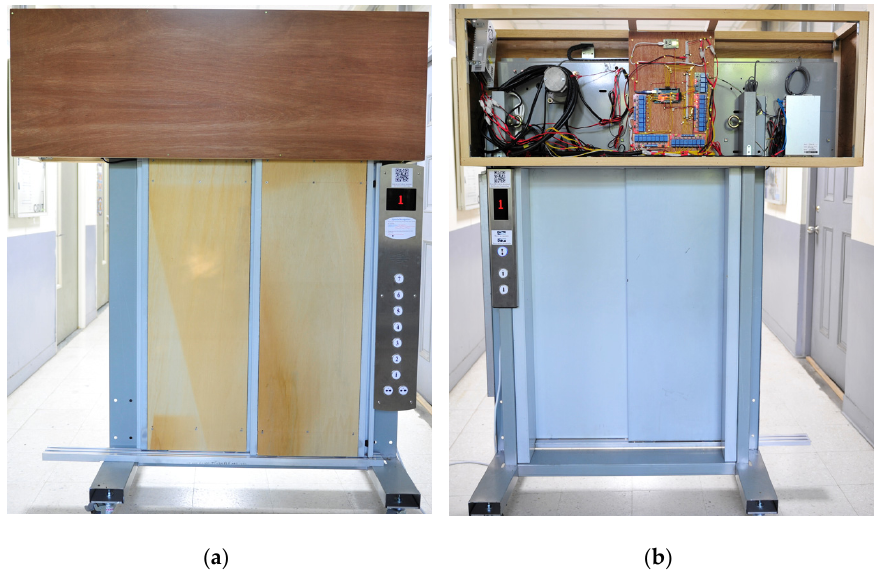
Figure 14. Elevation view of the elevator after installation. ( a ) Elevator car; ( b ) elevator hall.